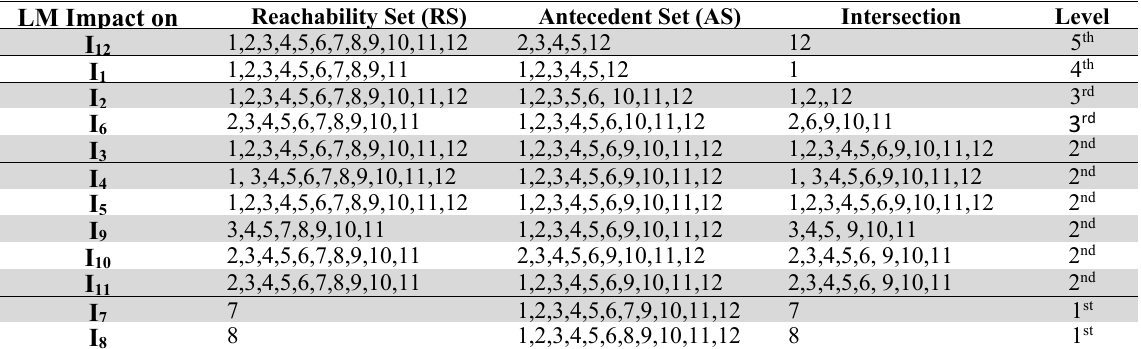
Level Partition LM Impact